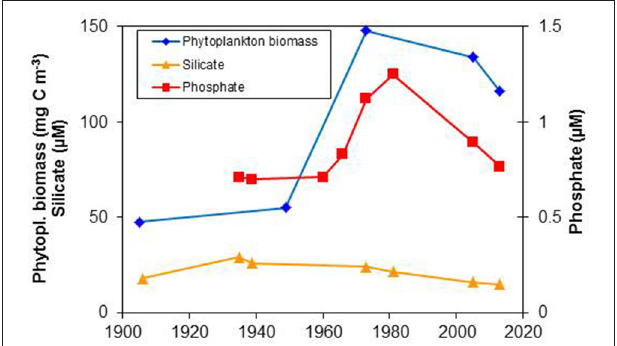
FIGURE 2 | Trends in the late-winter concentrations of phosphate and silicate as well as mean annual phytoplankton biomass (in carbon units) in the upper mixed layer of Kiel Bay. Data sources are provided in the